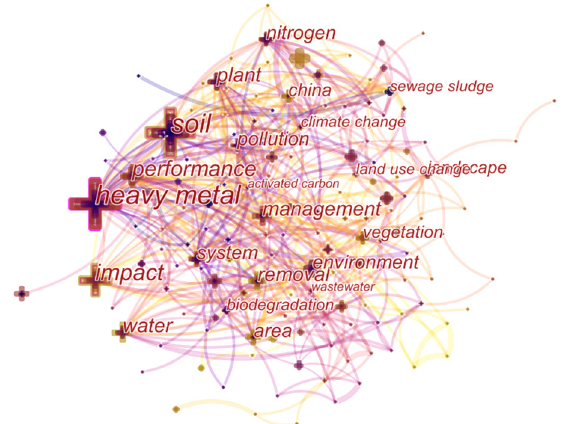
Figure 8. A visualization of the keyword network